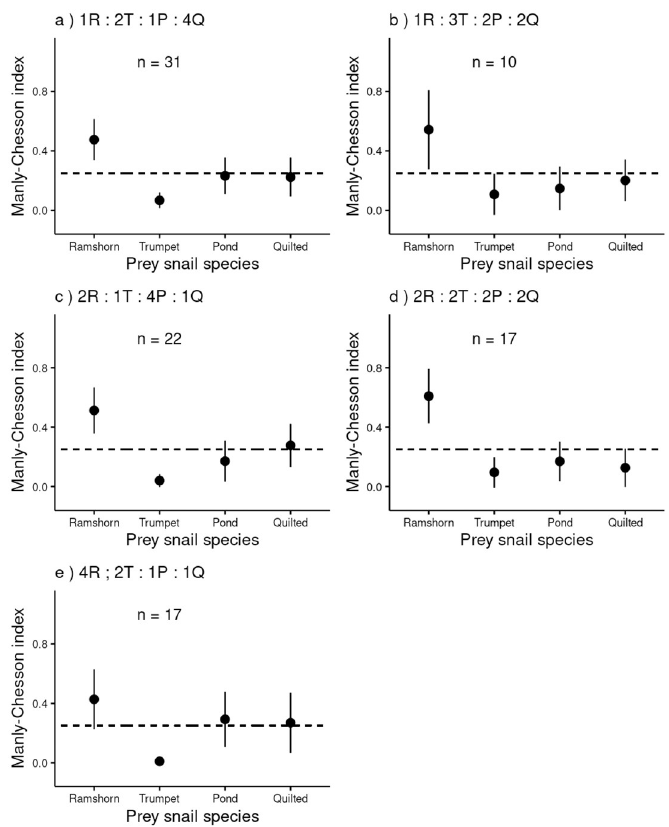
Fig 3. Prey selection in each treatment. Mean α ( ± 95% CI) of each prey type in each treatment (a-e) based on feeding without depletion. The prey abundance in a particular treatment is indicated in the label of each panel (altogether 8 snails were used in each treatment). In the case where the confidence interval overlaps with the dashed line (expected feeding under random prey selection) there is no selective feeding on a prey